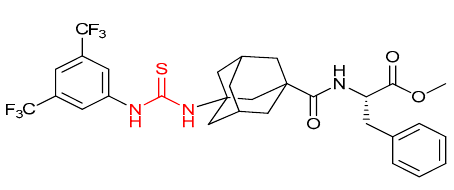
Figure 20. A peptide-like chiral thiourea [276].